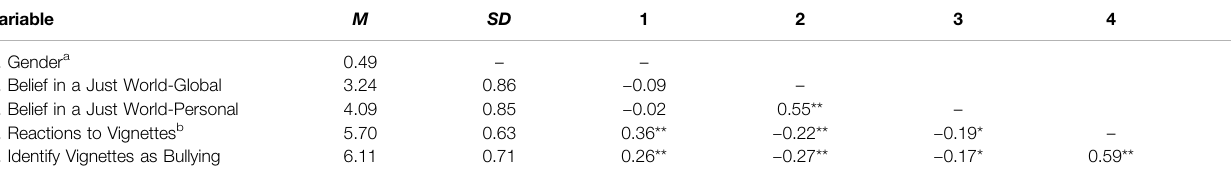
TABLE 2 | Descriptive statistics and Correlations, Study 2 ( n (cid:1) 197).